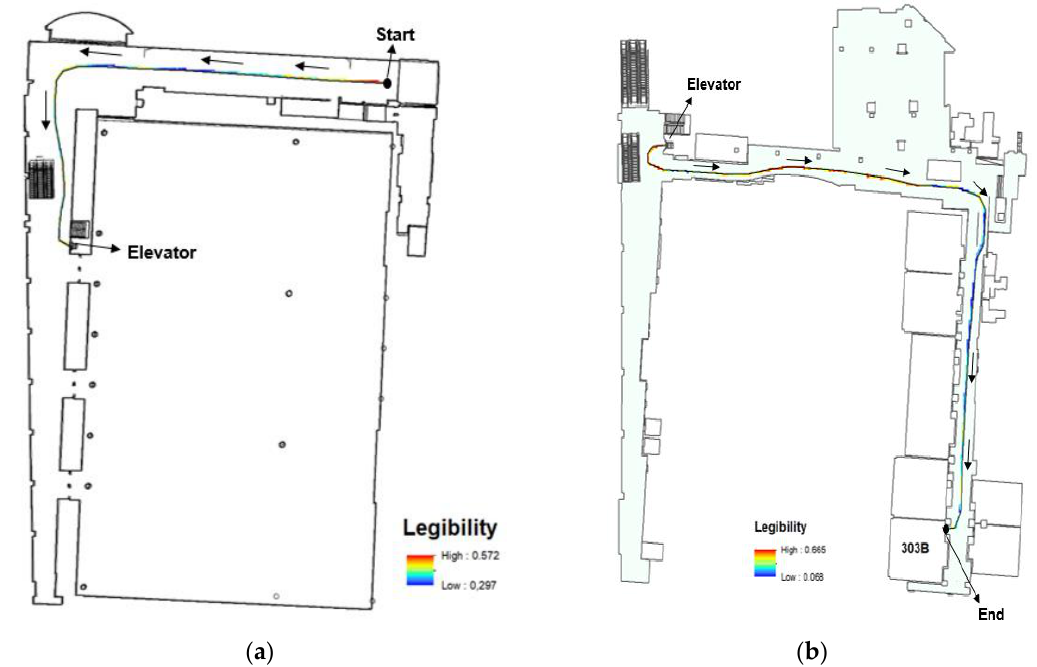
Figure 16. Legibility of a trajectory of a person using a wheelchair from ( a ) floor 4 to ( b ) floor 3.